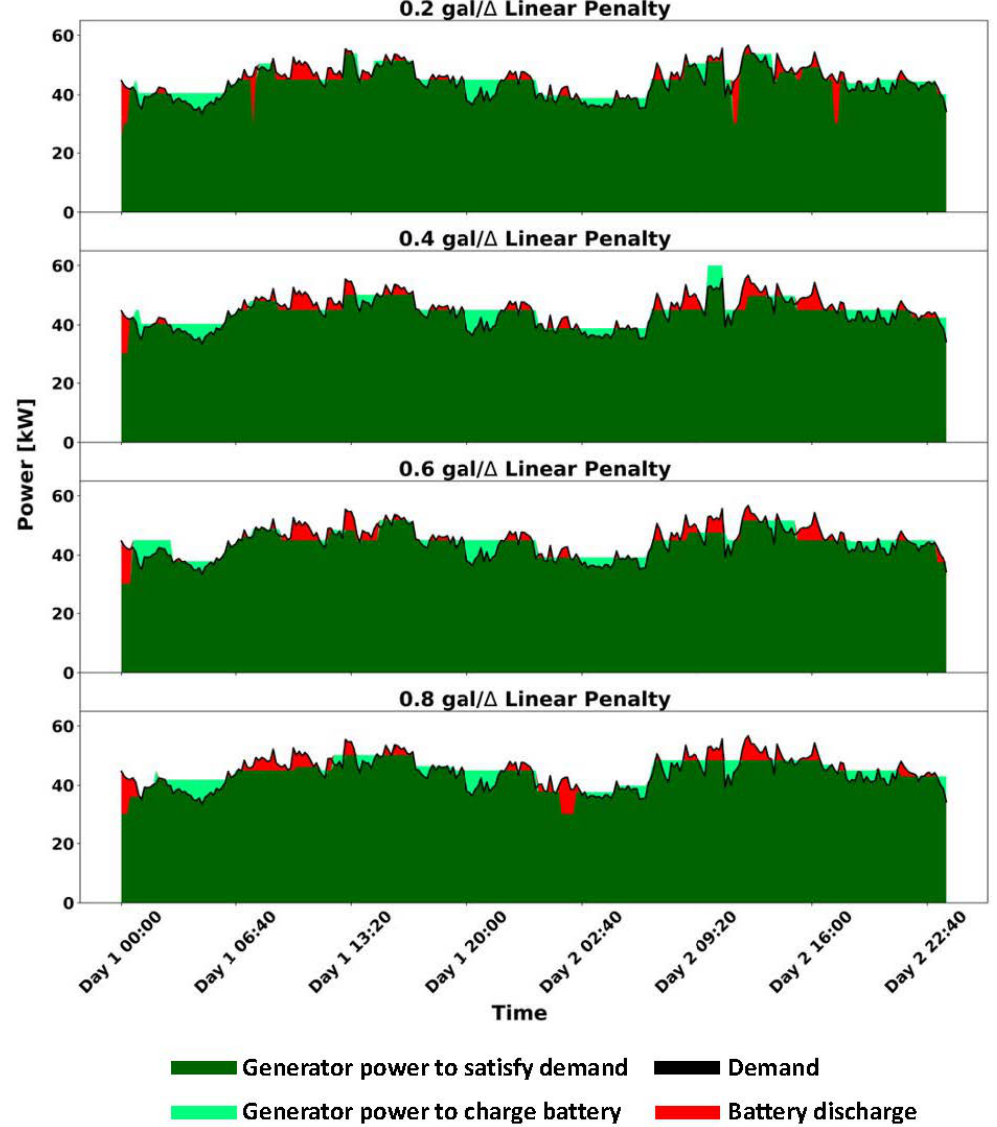
Figure 7. Power output plot based on linear penalty coefficients imposed on the generator for the summer demand scenario. Table 1. Optimal fuel consumption and power output with various linear penalties for the summer demand